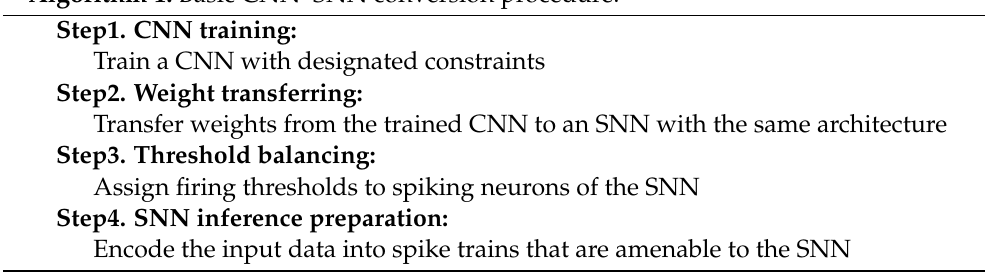
Algorithm 1: Basic CNN–SNN conversion